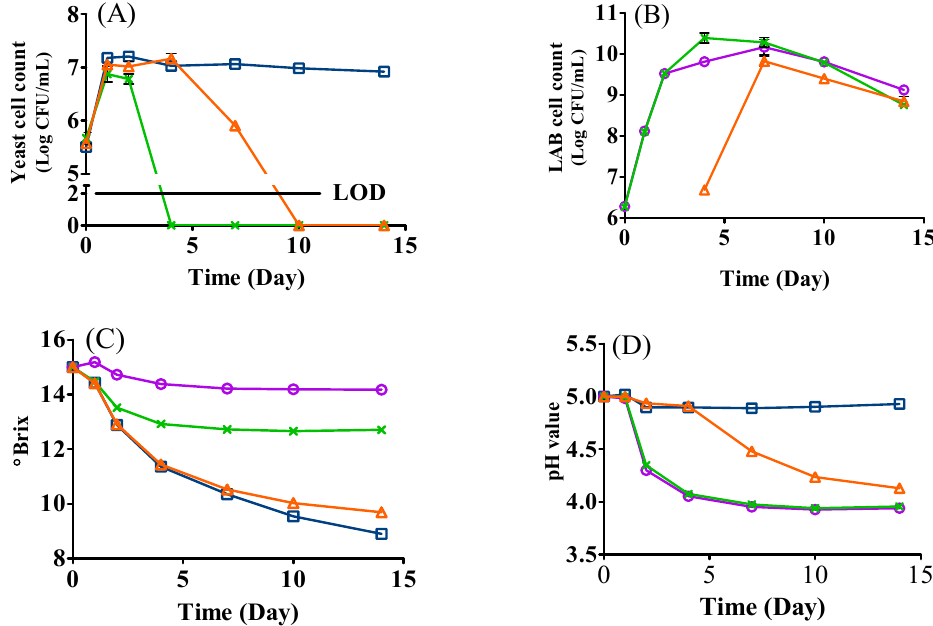
Figure 1. Changes in cell counts of L. thermotolerans Concerto ( A ), L. plantarum ML Prime ( B ), °Brix ( C ), and pH ( D ) during the fermentation of SCG hydrolysates. ( □ ) LT: mono-inoculation of L. thermotolerans Concerto; ( ○ ) LP: mono-inoculation of L. plantarum ML Prime; (X) LT+Co-LP: co-inoculation of L. thermotolerans Concerto and L. plantarum ML Prime; ( △ ) LT+Se-LP: sequential inoculation of L. thermotolerans Concerto and L. plantarum ML Prime at day 4. LOD, limit of detection for yeast was 2 log CFU/mL. LOD, limit of detection.